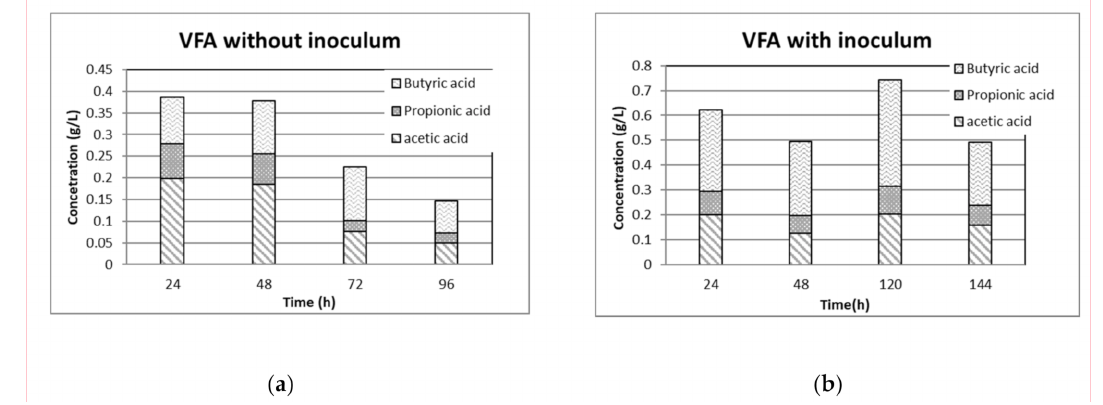
Figure 5. VFA concentrations during fermentation with main acids: ( a ) without inoculum; ( b ) with inoculum.